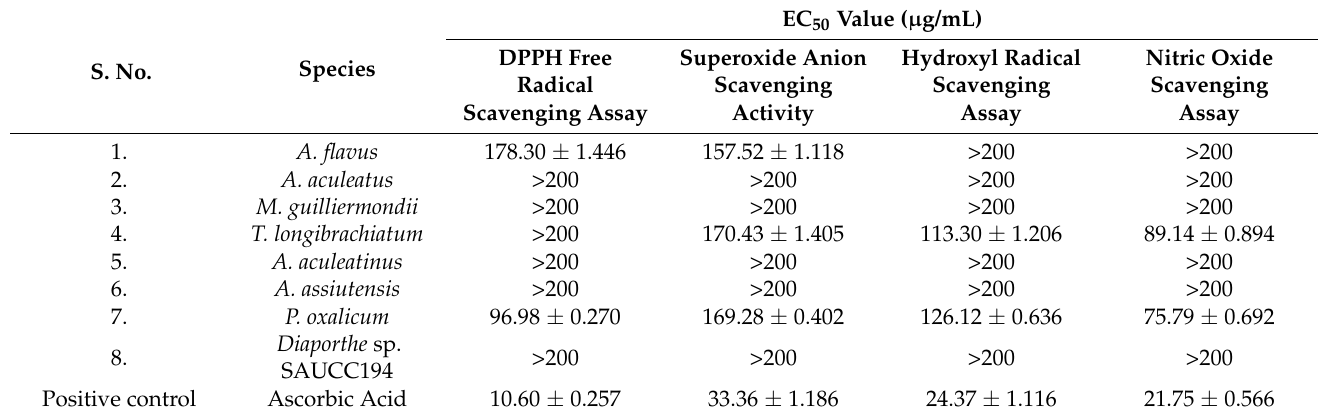
Table 2. Antioxidant activity of EA extracts of identified fungal strains associated with the leaf of A. rohituka